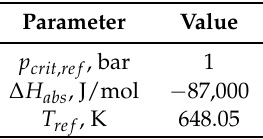
Table 6. Absorbent equilibrium pressure temperature dependence